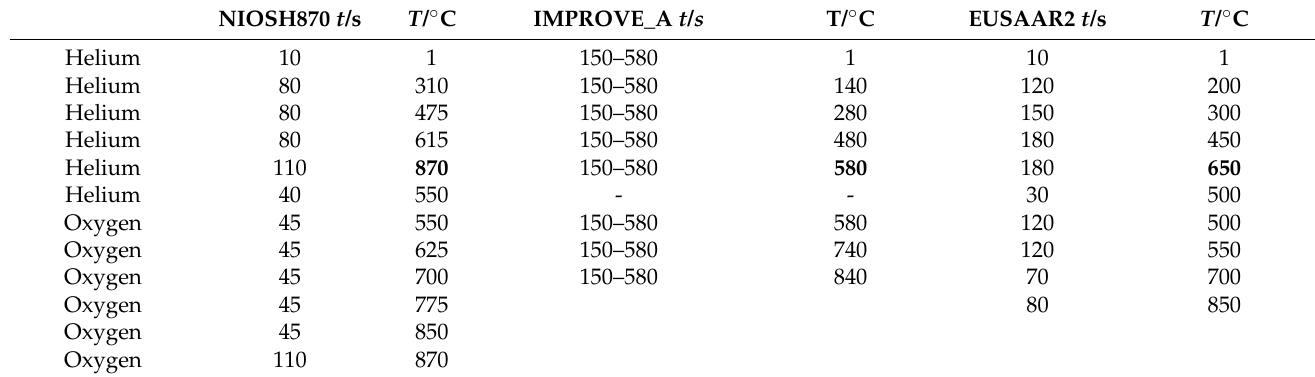
Table 1. Comparison of three TOT protocols; the maximum temperature is highlighted in bold.